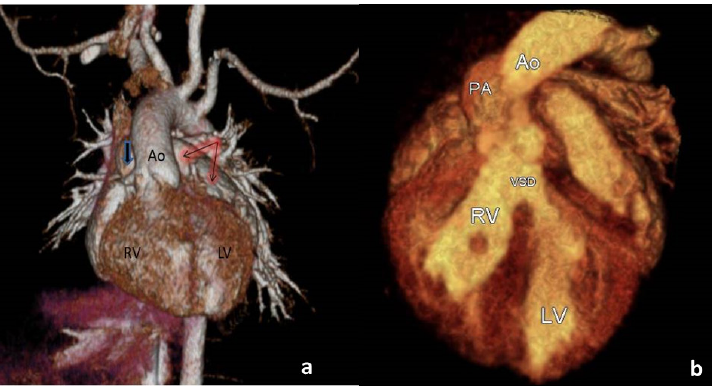
Fig. 2 - Three-dimensional computed tomography reconstruction image (a) representing the pulmonary trunk (bold arrow), aorta (Ao), and left juxtaposition of both atrial appendages (red shaded arrows); volume-rendering computed tomography image elaborating the anatomical relations in DORV (b). LV=left ventricle; PA=pulmonary artery; RV=right ventricle; VSD=ventricular septal defect